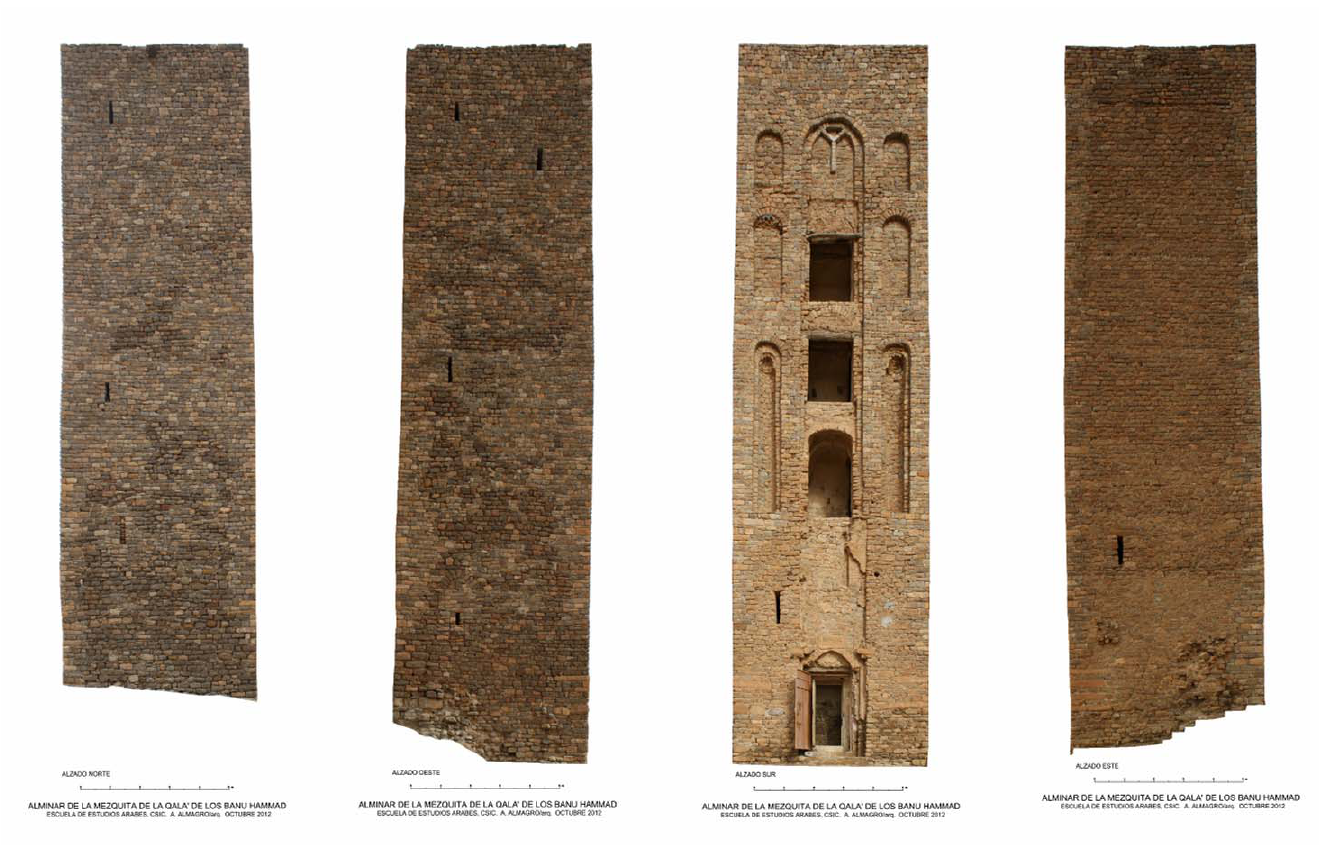
Figure 11. Photo rectifications of the façades of the minaret of the Qala of Beni Hammad.